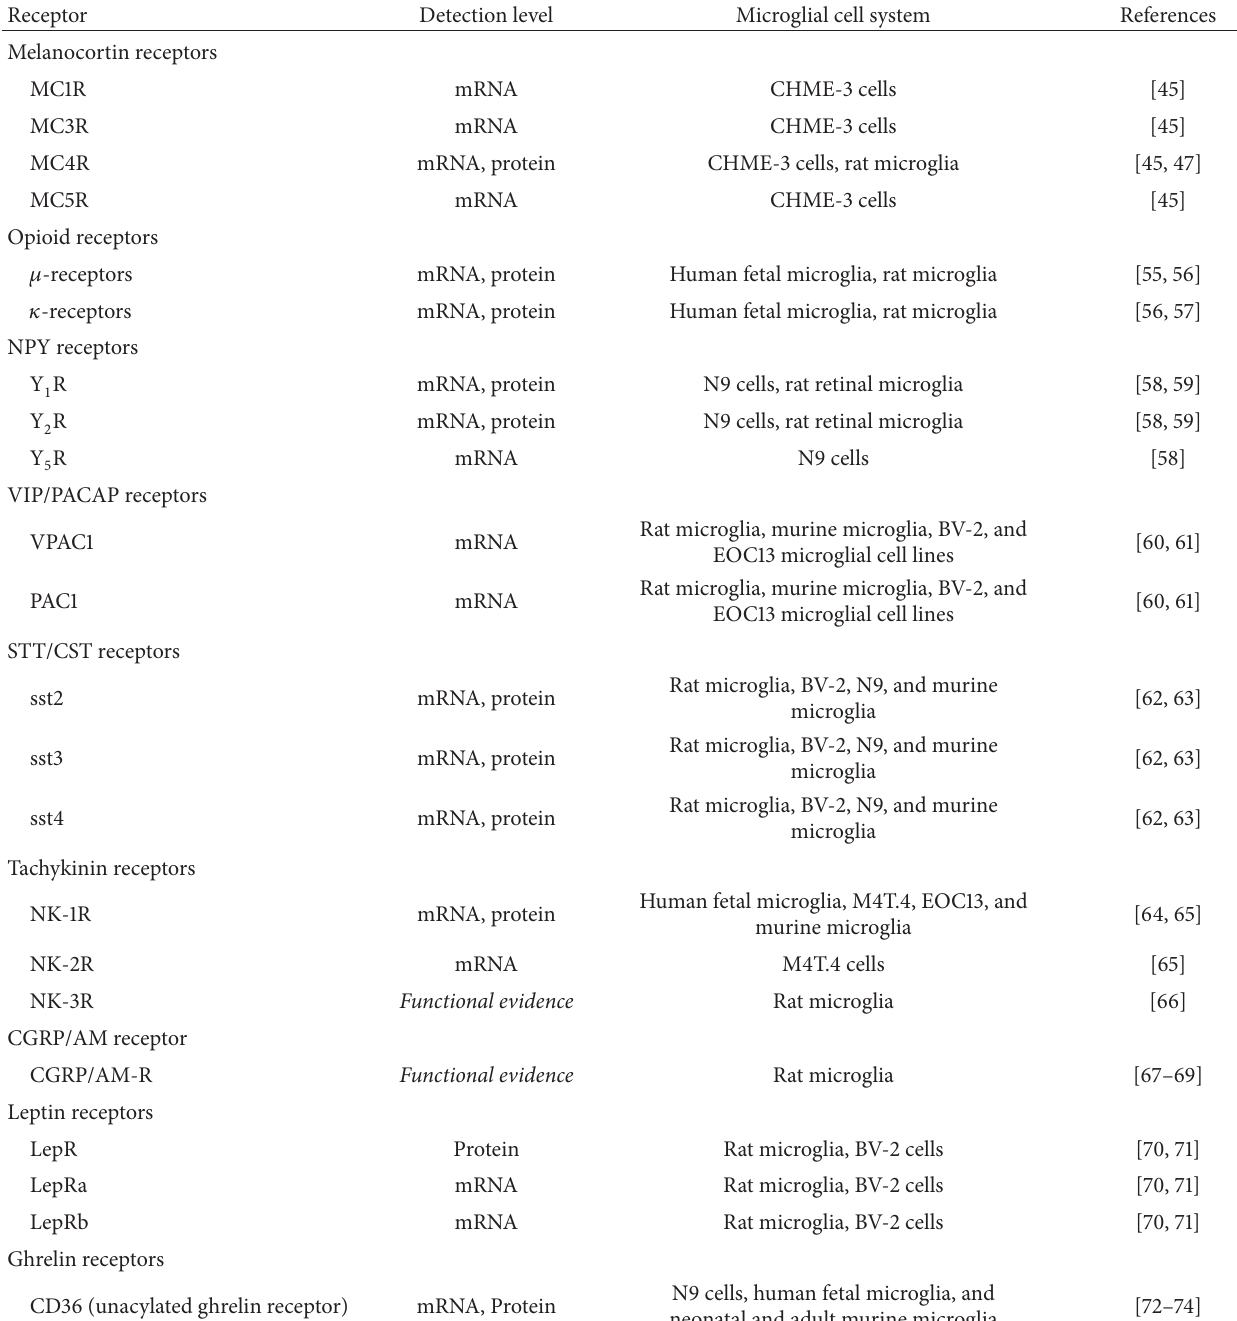
Table 1: Expression of neuropeptide receptors in microglial